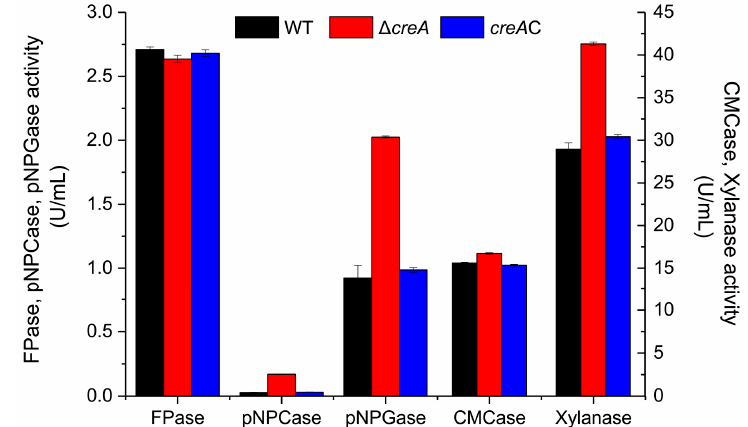
Figure 4. Cellulase activity of H. insolens WT, the creA disruption mutant, and creA complement strains in the presence of glucose. All strains were cultured in shake flasks at 42 °C for 24 h with 2.0% ( w / v ) glucose as the carbon source.